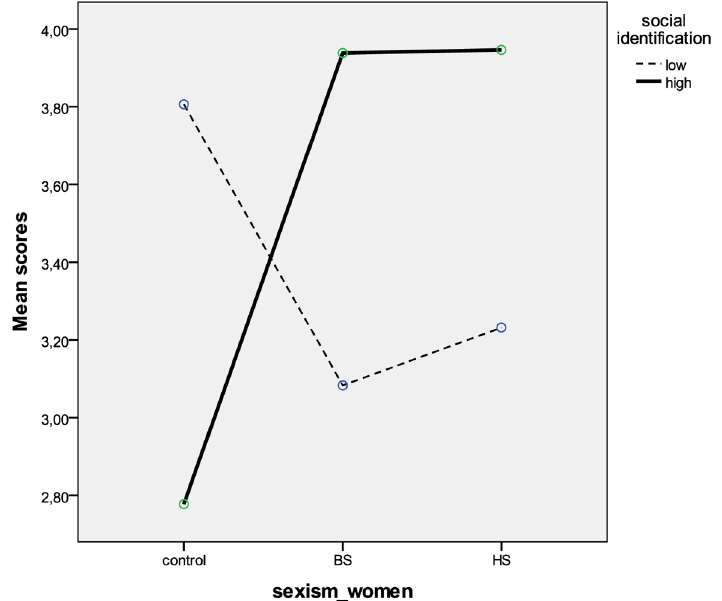
Figure 1. Interaction between experimental conditions and identification on women’s perception of being potential